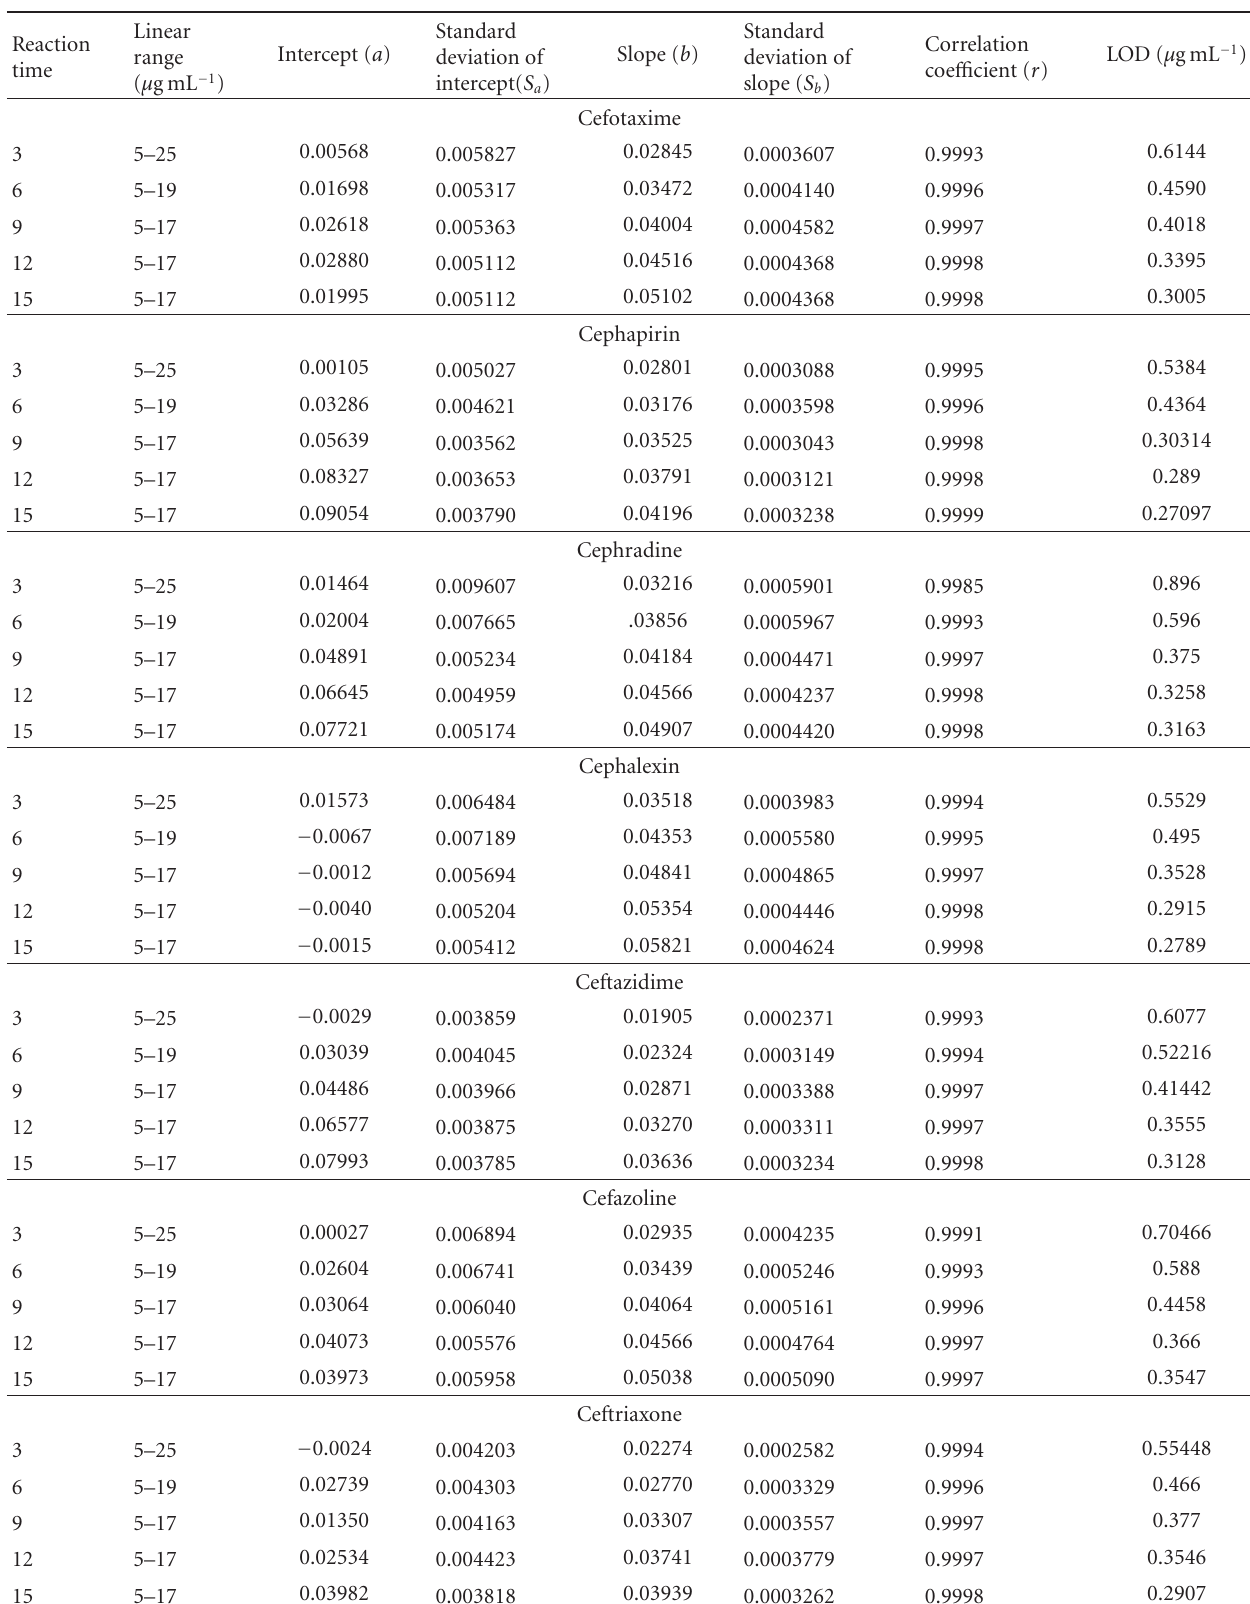
Table 3: Analytical parameters for fixed time method of the kinetic spectrophotometric parameter for determination of investigated